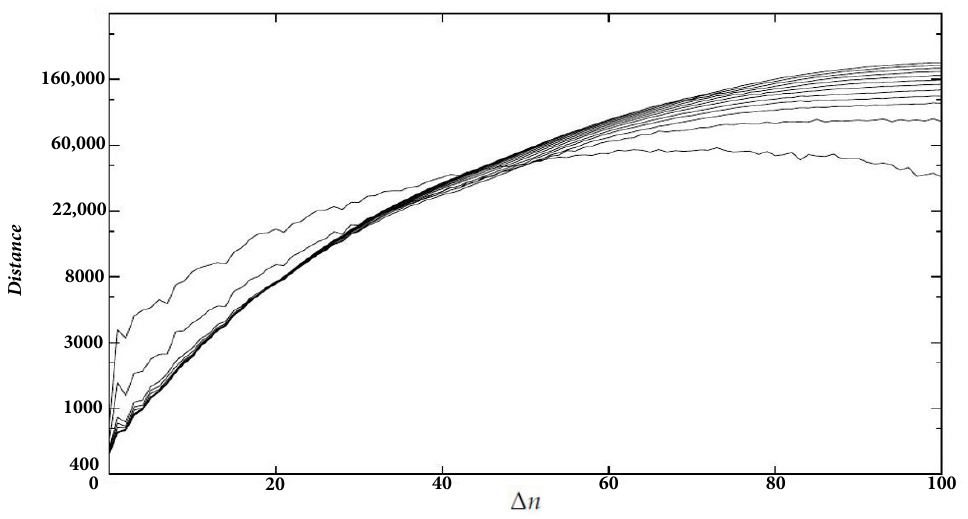
Figure 8. e S ( ∆ n ) for coop2 ( ε =